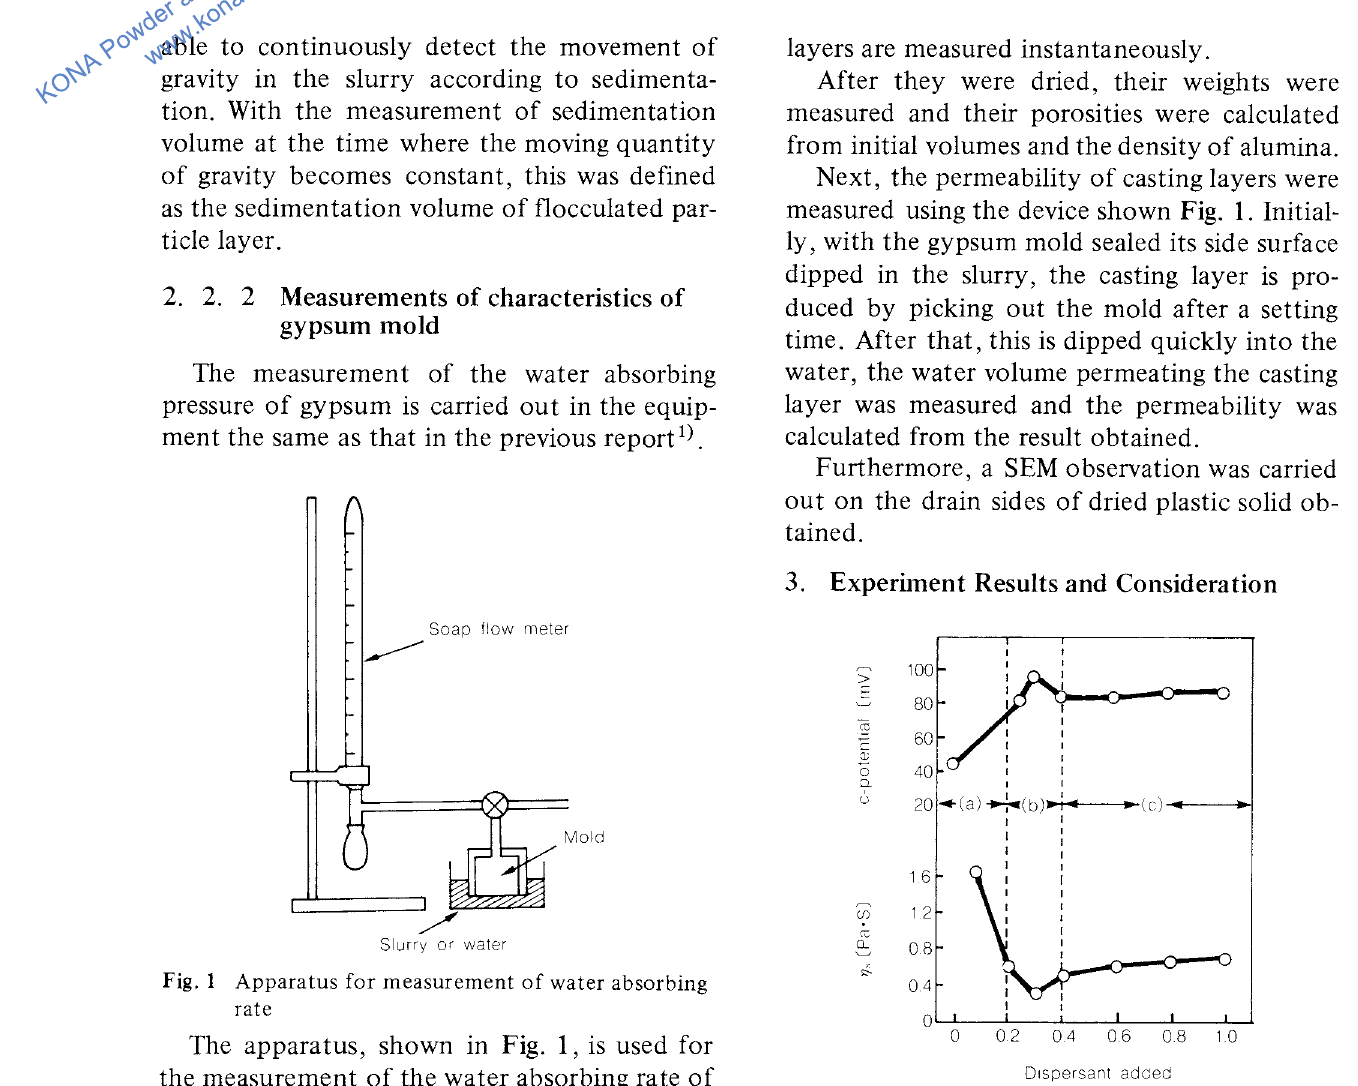
Fig. 2 Relation between apparent viscosity (T/s), ~-potential and concentration of